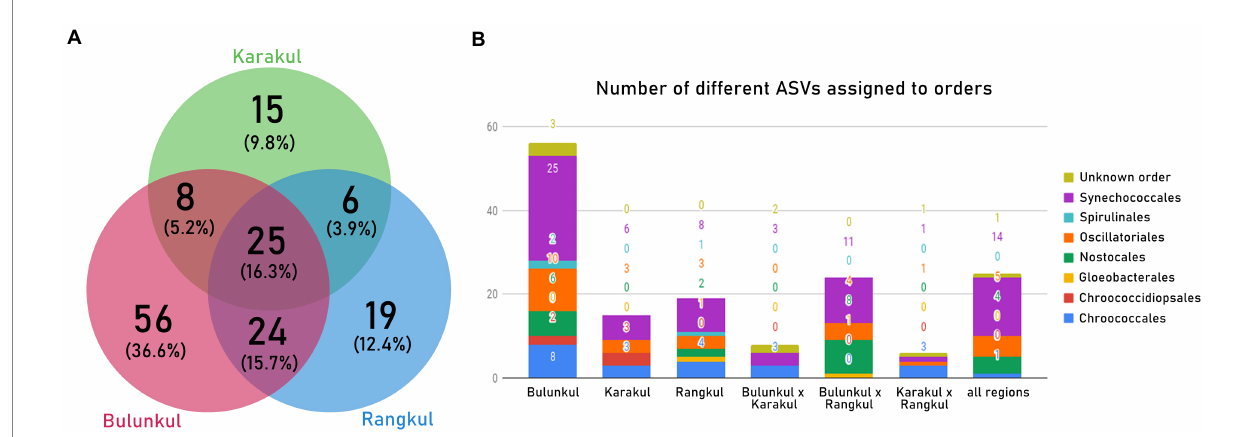
FIGURE 4 (A) Venn diagram showing the number of unique Oxyphotobacteria ASVs for each region as well as ones common for 2 or all regions. (B) ASVs from each part of the Venn diagram assigned to orders.